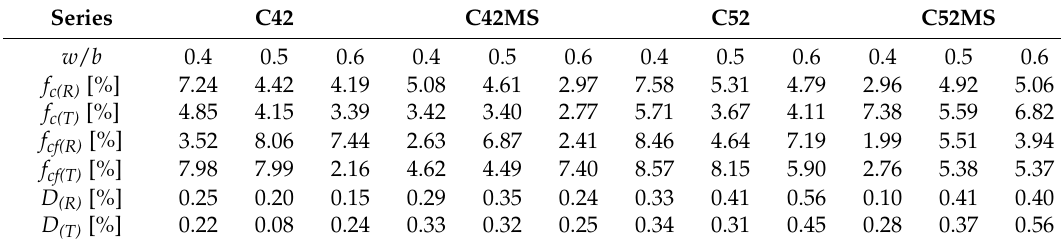
Table 3. Values of the coefficients of